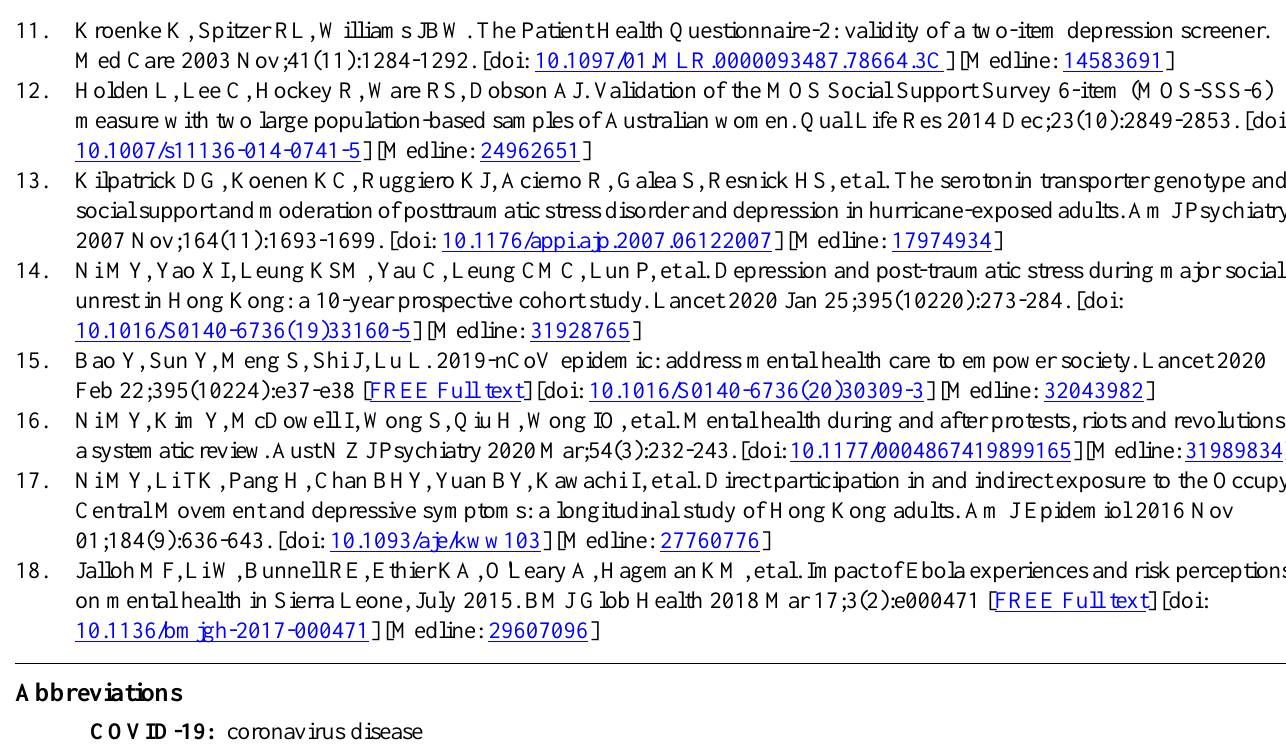
GAD: Generalized Anxiety